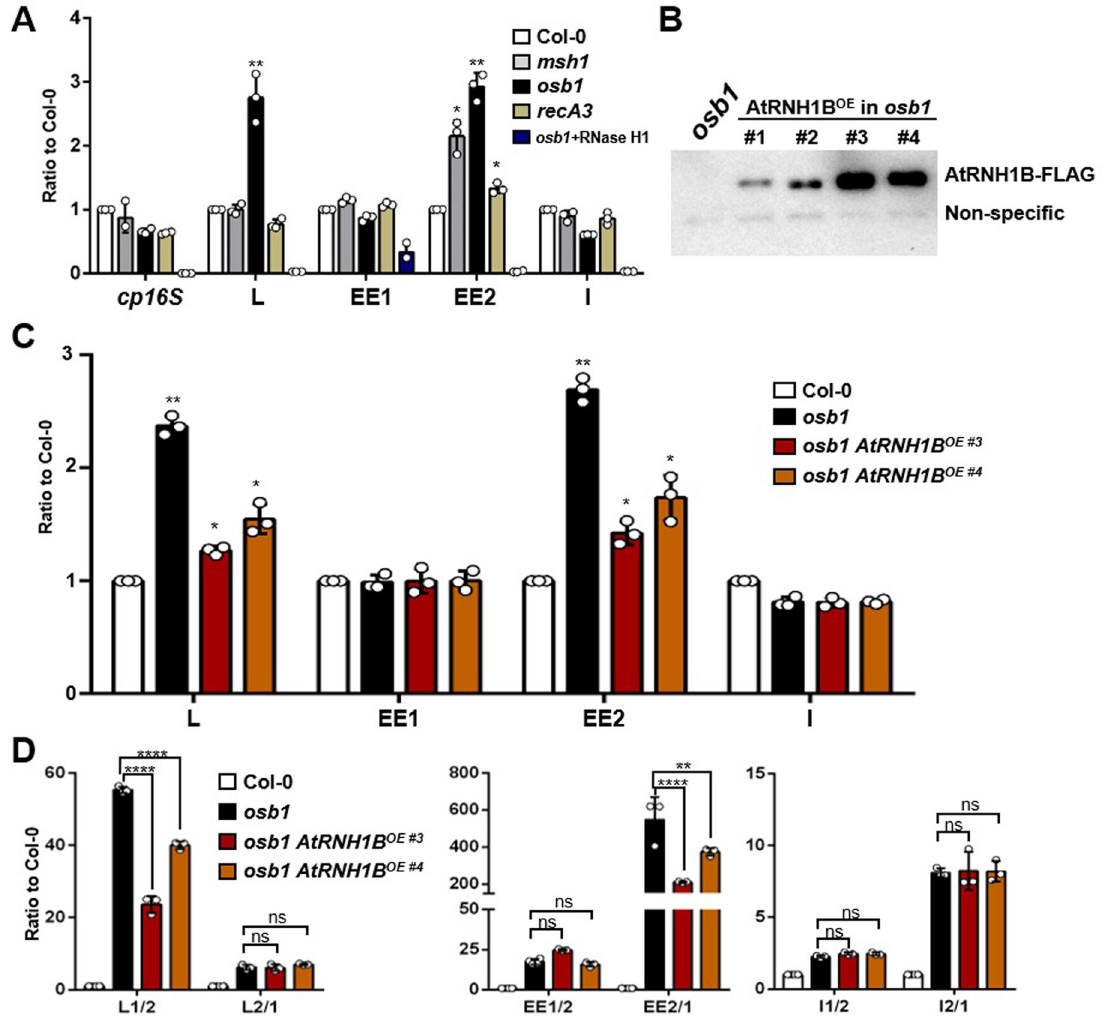
Fig 9. OSB1 restricts HR by inhibiting R-loop formation at IRs. (A) DRIP-qPCR of Col-0, msh1 , osb1 , and recA3 seedlings. Data are normalized to Col-0 and shown as mean values ± SD; circles show the original data of 3 replicates. One-way ANOVA compared to Col-0 for each primer. � , p < 0.05; �� , p < 0.01. (B) Immunoblot analysis of 35Spro : AtRNH1B-FLAG (AtRNH1B OE #1- #4) in osb1 using anti- FLAG antibody. osb1 was used as a negative control. The unspecific band below AtRNH1B-FLAG is the loading control. (C) DRIP-qPCR of Col-0, osb1 , and osb1 AtRNH1B OE (#3 and #4) seedlings. One-way ANOVA compared to Col-0 for each primer. � , p < 0.05; �� , p < 0.01. (D) qPCR of the crossover products (as depicted in A) of repeats L, EE, and I from Col-0, osb1 , and osb1 AtRNH1B OE (#3 and #4). One-way ANOVA compared to osb1 for each primer. ns, no significance; �� , p < 0.01; ���� , p < 0.0001. The data underlying this figure can be found in S1 Data and S1 Raw Images. ANOVA, analysis of variance; DRIP, DNA:RNA hybrid immunoprecipitation; HR, homologous recombination; IR, intermediate-sized repeat; OE, overexpression; OSB1, ORGANELLAR SINGLE-STRANDED DNA BINDING PROTEIN1; qPCR, quantitative PCR; SD, standard